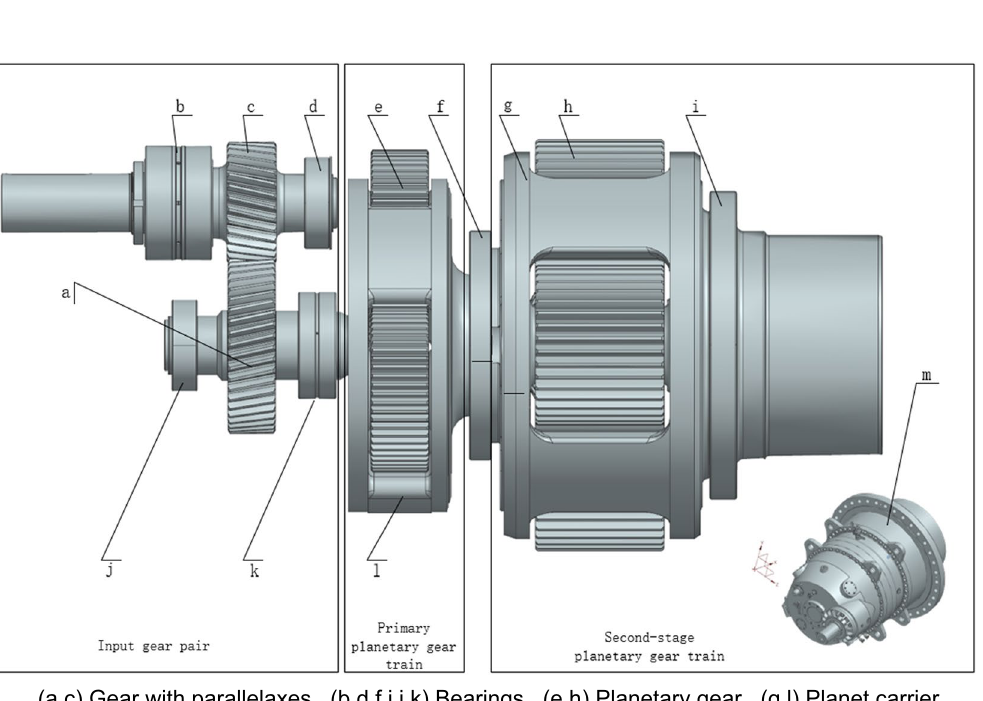
Figure 1. Gearbox three-dimensional model.